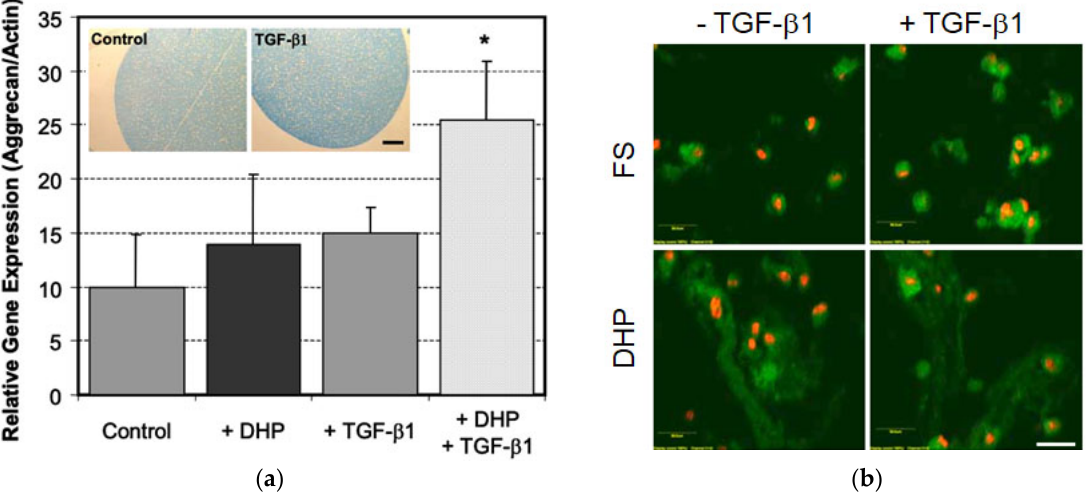
Figure 4. ( a ) Human BMSCs encapsulated in alginate were cultured in chondrogenic media +/- ap- plied dynamic hydrostatic pressure (DHP, 3 MPa, 0.33 Hz, one hour per day) or free-swelling (FS) +/- 10 ng/ mL TGF- β 1. Inset: Alcian blue staining for glycosaminoglycans, scale bar = 250 µm. Ag- grecan mRNA levels normalized to β -actin on day 14 (* p < 0.025, n = 3). ( b ) Type II collagen staining (green) with ethidium homodimer stained nuclei (red) on day 14. Scale bar = 50 µm.